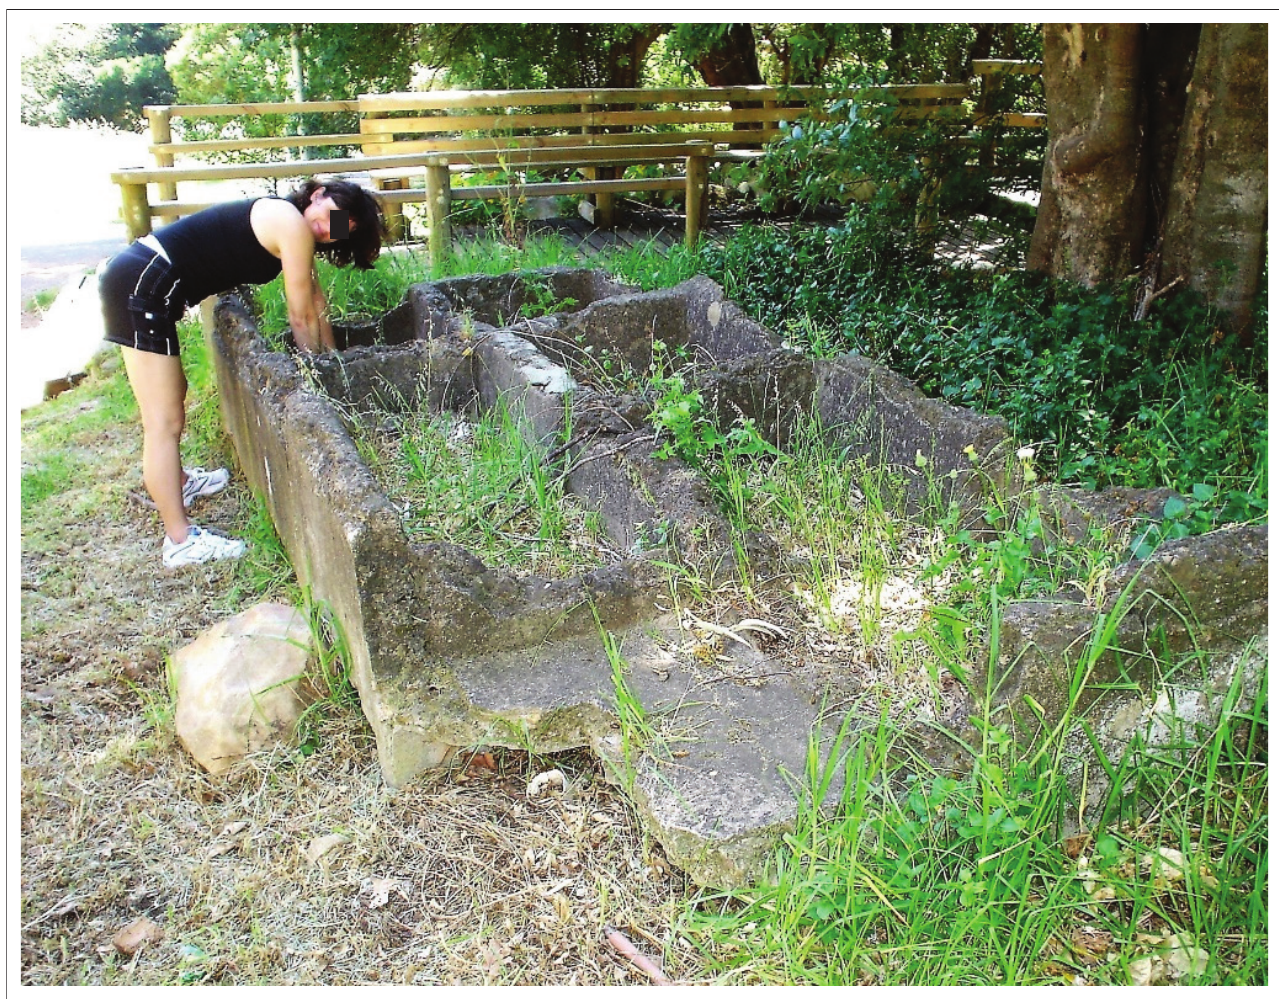
FIGURE 1: Remains of the wash troughs next to the Platteklip